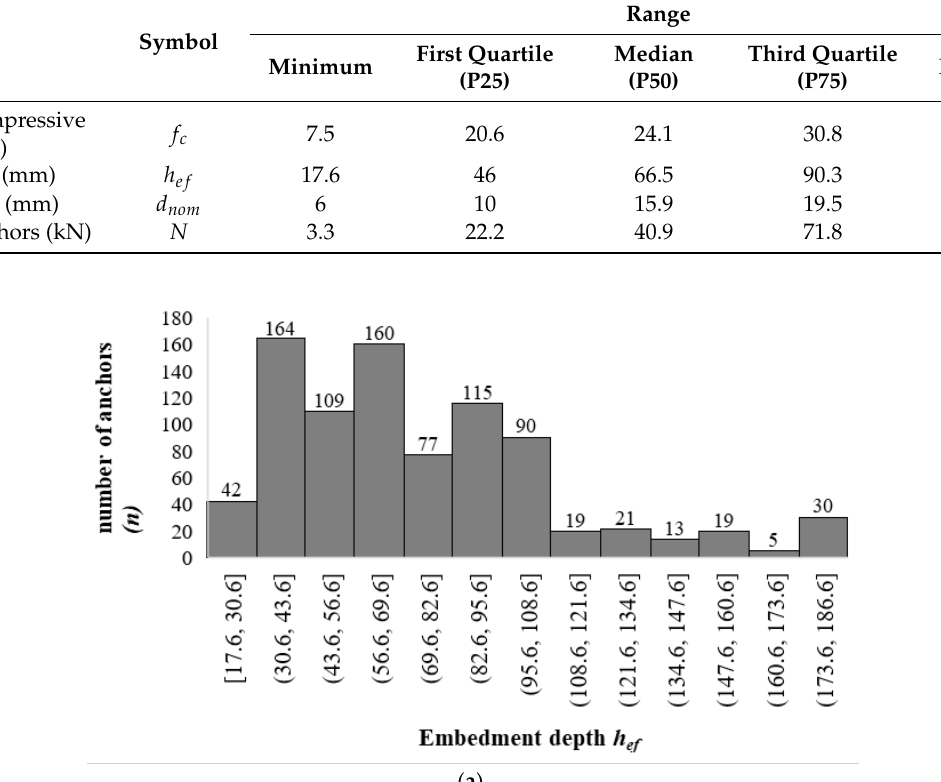
Table 1. Statistical summary of the experimental database.